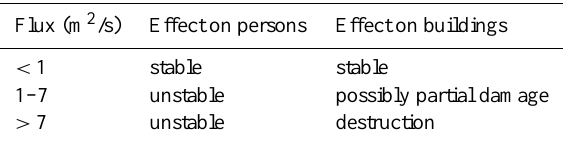
Table 1. Flux classes and stability of persons and